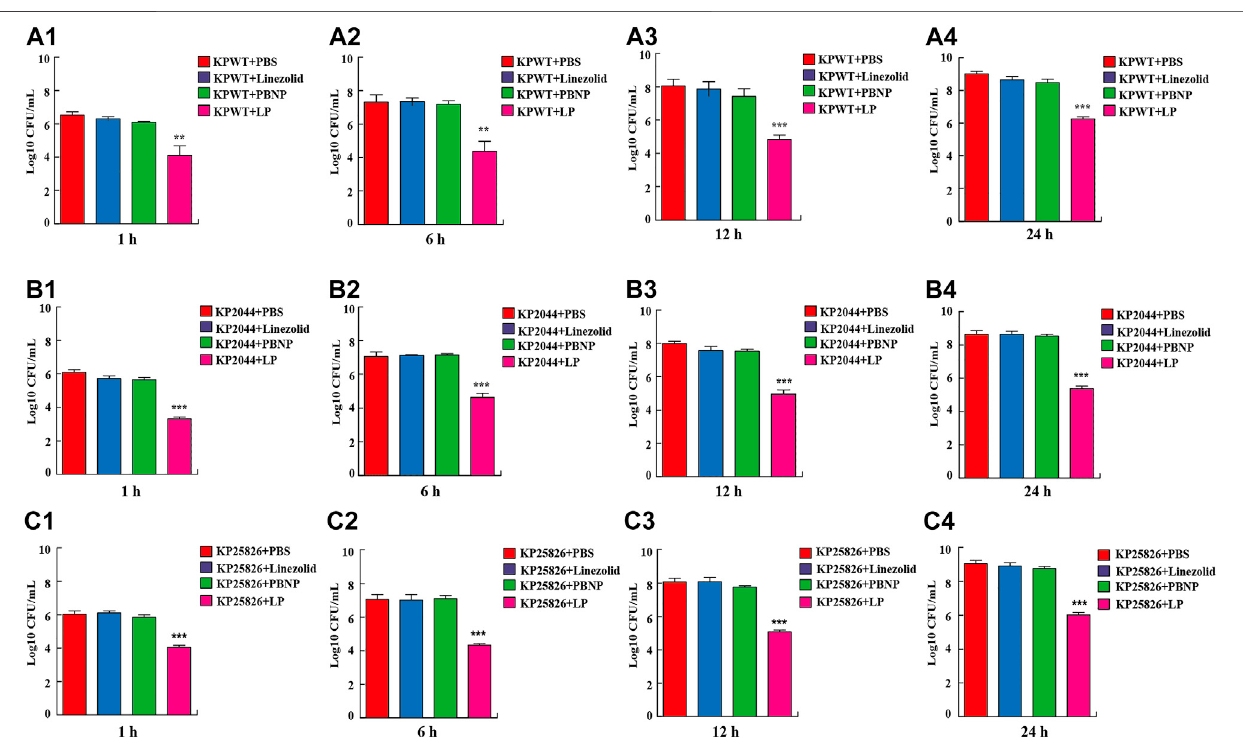
the formulas: FIC Index = FIC A + FIC B, FIC A = MIC A+B /MIC A , FIC B